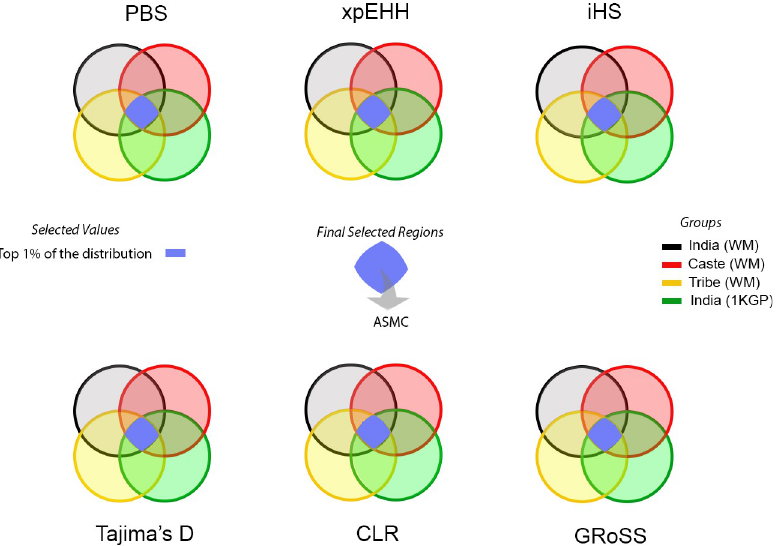
Fig 1. Schematic representation of the approach to identify putative selective regions. We applied six different methods to identify outliers (top 1% results) and selected regions that were observed in all population groups and were outliers for at least two independent methods. Additionally, we performed analyses using a novel coalescence-based method implemented in the program ASMC.